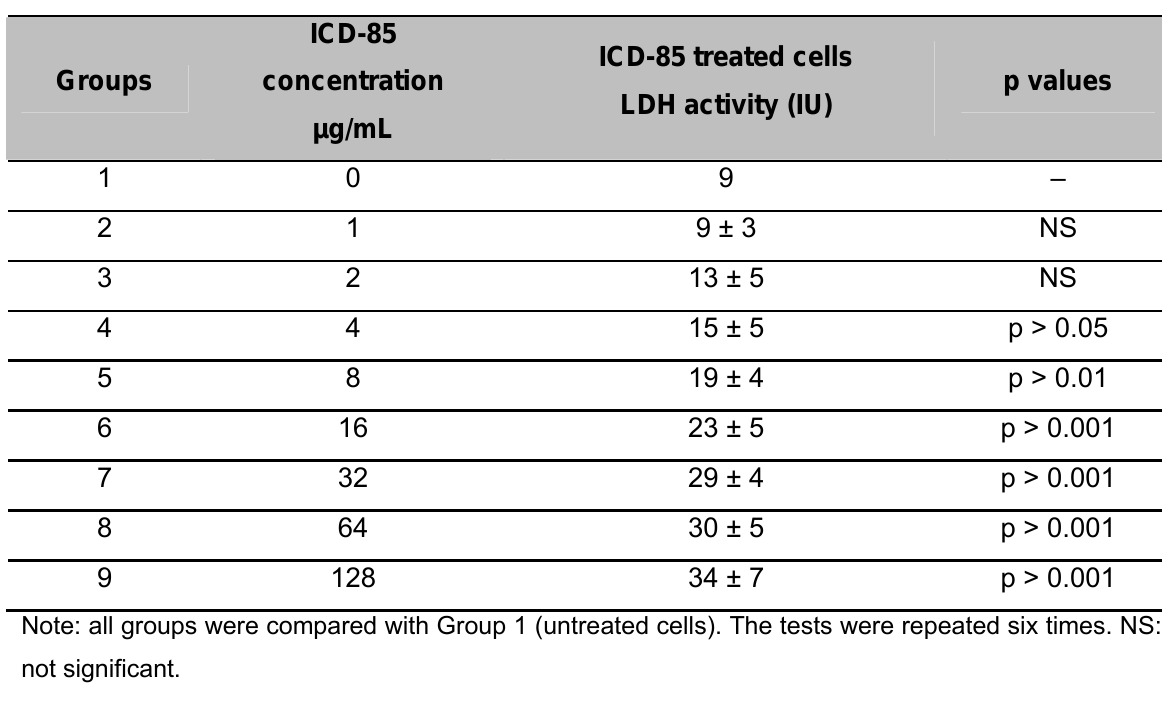
Table 1. Comparison of LDH activity in cultured media 30 min. after incubation of MDA-MB-231 cell line treated with ICD-85